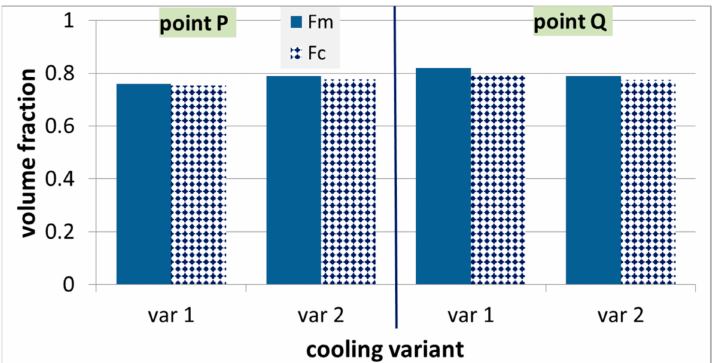
Figure 17. Measured and calculated volume fraction of ferrite in steel B after physical simulations described in Section